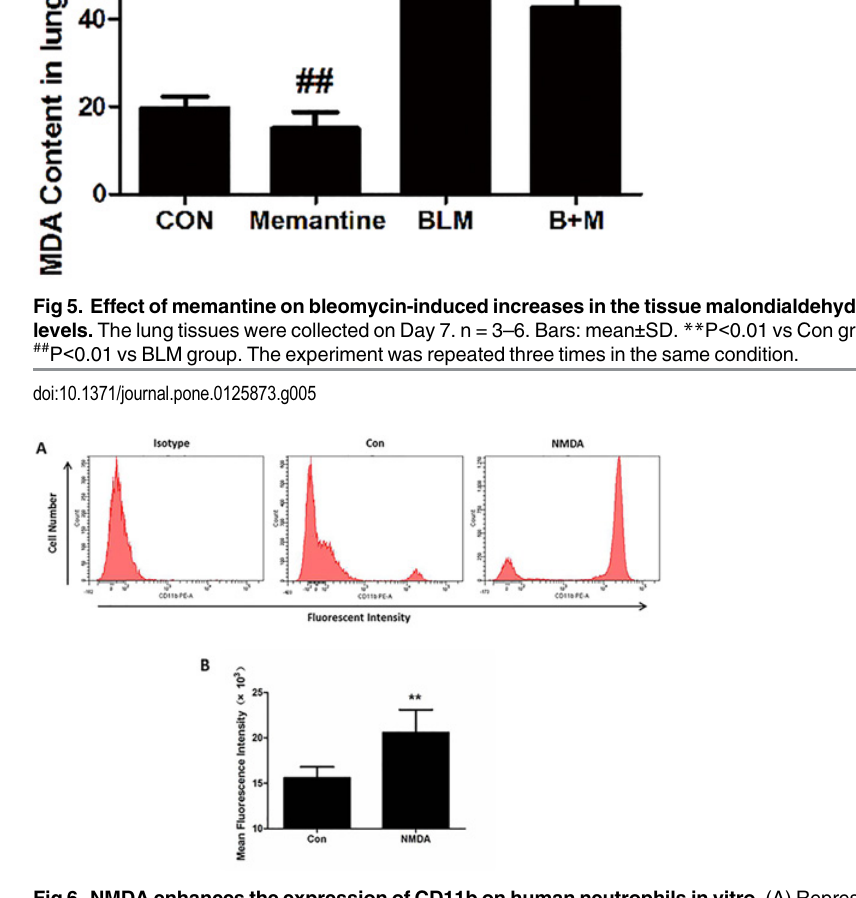
Fig 6. NMDA enhances the expression of CD11b on human neutrophils in vitro. (A) Representative flow cytometry plots detecting CD11b on neutrophils at 4h after normal saline or 10 -6 mol/L NMDA exposure are shown. (B) Mean fluorescence intensity was measured to evaluate the expression of CD11b on neutrophils in different groups. n = 3. Bars: mean ± SD. * P < 0.05 vs Con group. The experiment was repeated three times in the same